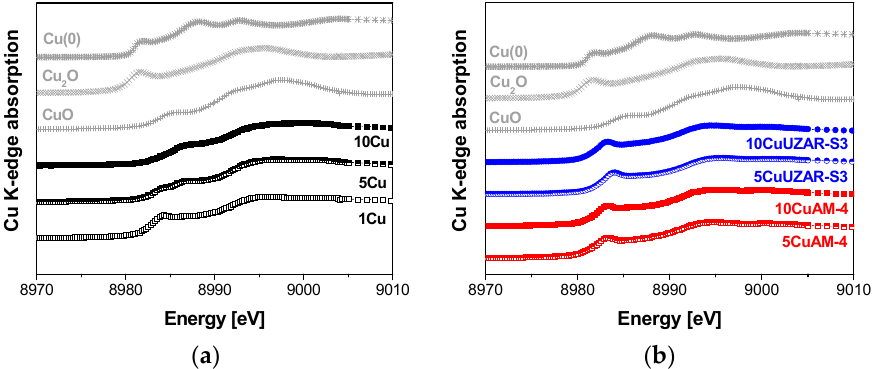
Figure 4. Normalized Cu K-edge XANES spectra for CS:PVA membrane samples filled with unsupported Cu NPs ( a ) and Cu-exchanged layered titanosilicate AM-4 and stannosilicate UZAR-S3 ( b ). References used for the linear combination (Cu foil, Cu 2 O, and CuO) are also shown above.